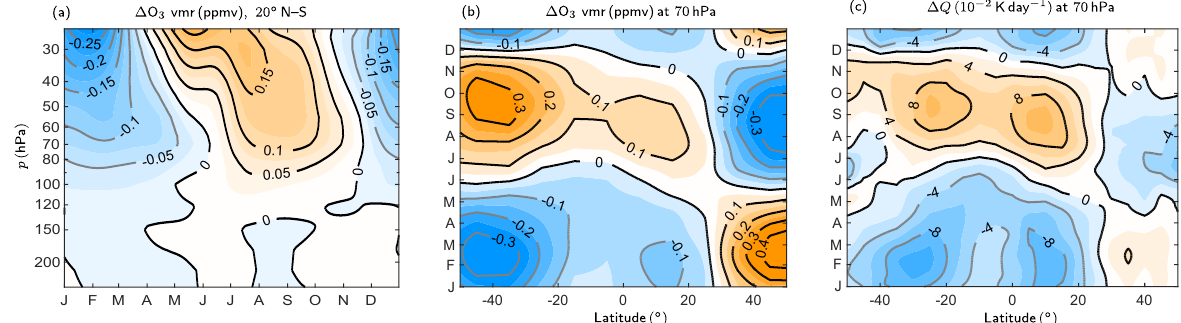
Figure 2. Ozone volume mixing ratio (ppmv) from the SWOOSH dataset plotted as a difference from the annual mean (a) averaged between 20 ◦ N and 20 ◦ S and (b) at 70hPa. (c) The total change in heating rate (longwave and shortwave) due to the annual ozone cycle, assuming that temperatures are fixed at the annual average